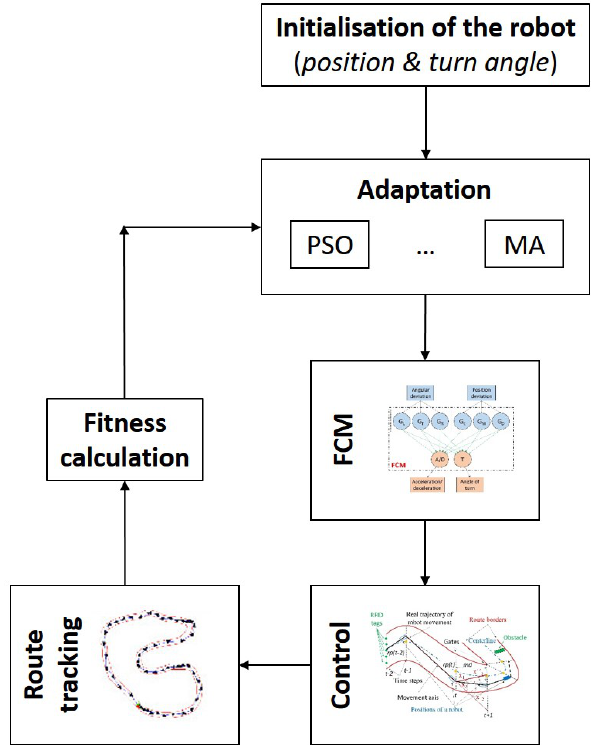
Figure 11. Block diagram of the proposed research